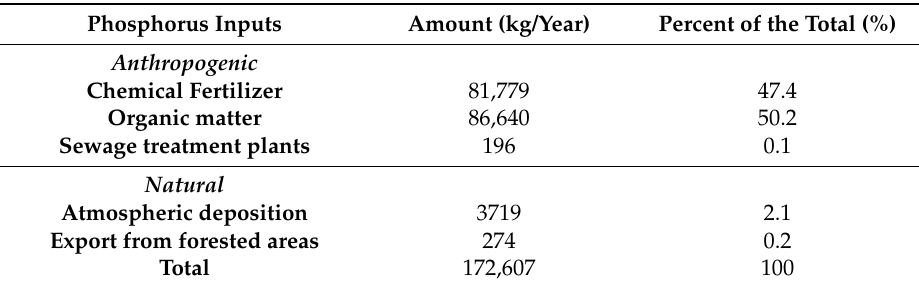
Table 5. Summary of phosphorus inputs in the Haean